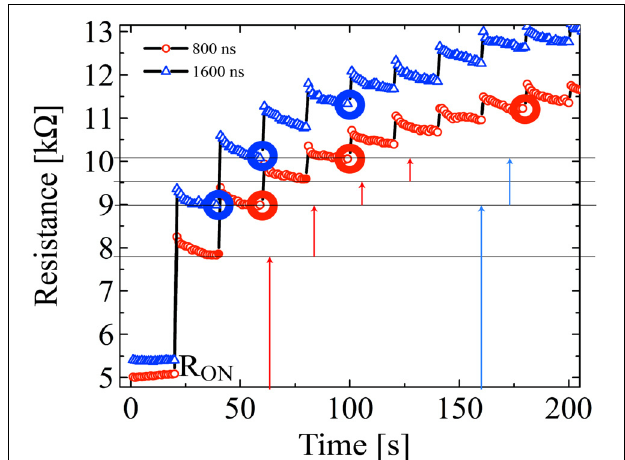
FIGURE 5 | Memristor programming. The data points represent the resistance after switching from a pre-defined ON-state with a pulse width of t A = 8 · 10 − 7 s (red) and t B = 16 · 10 − 7 s (blue). The vertical lines between the data points are the indicators for pulses that were applied. The horizontal lines are the programmed memristor states. The long time relaxation after applying the switching pulse is related to back-switching and relaxation of polarization